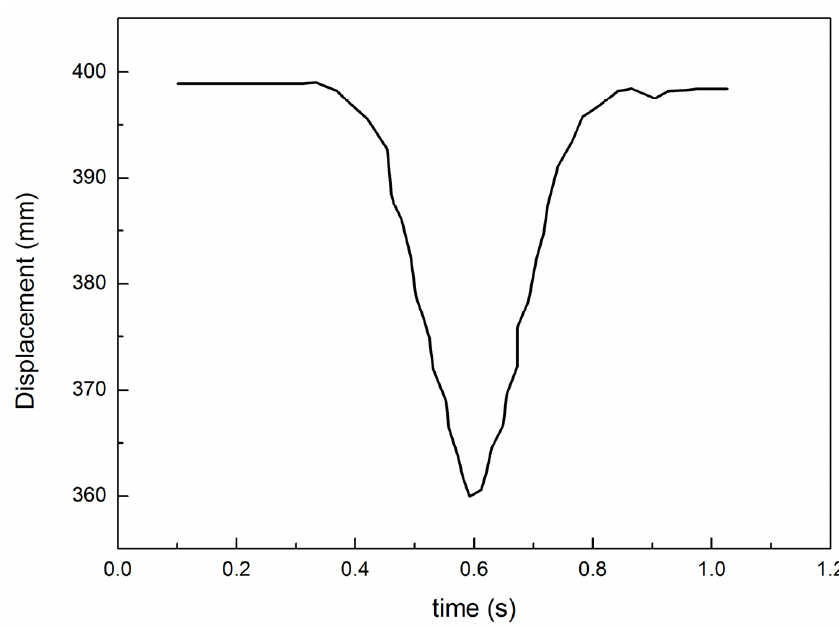
Figure 10. Displacement of the cantilever beam calculated by the numerical simulation.